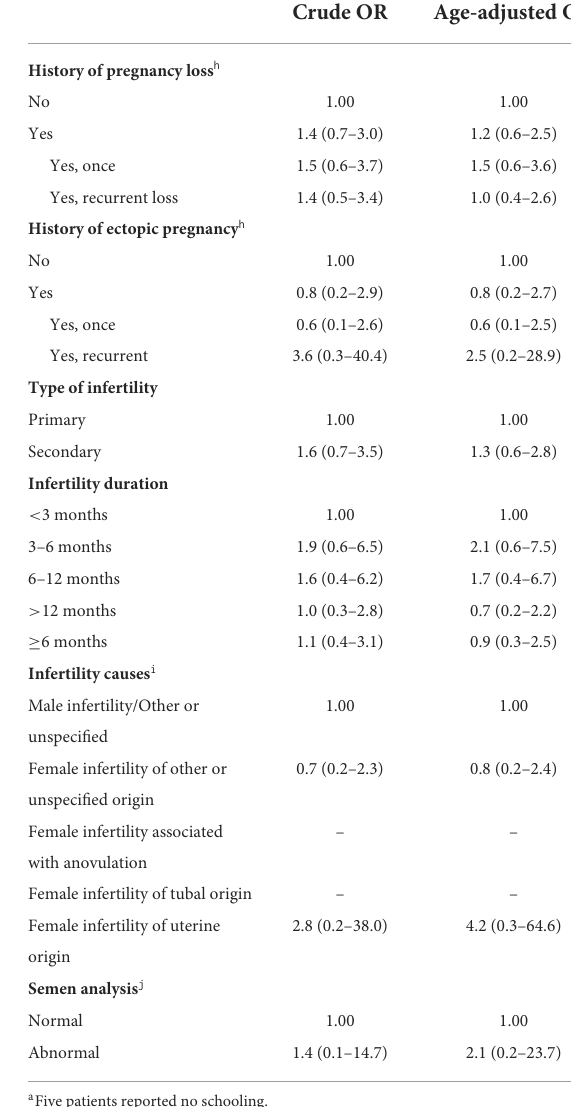
a Fivepatientsreportednoschooling. b DiabetesMellitusofanytypeincludingGDM. c Cardiovasculardisordersofanytypeincludinghighbloodpressure. d ChronicrespiratorydiseasesincludeOCPD,asthmaandTB. e Thyroiddysfunctionsofanytype. f Otherchronicdiseasesincludecancer,allergy,anemia,PCOS,PMDD. g Currently or during the past 3 months, h Sample size includes females only (N = 255), i